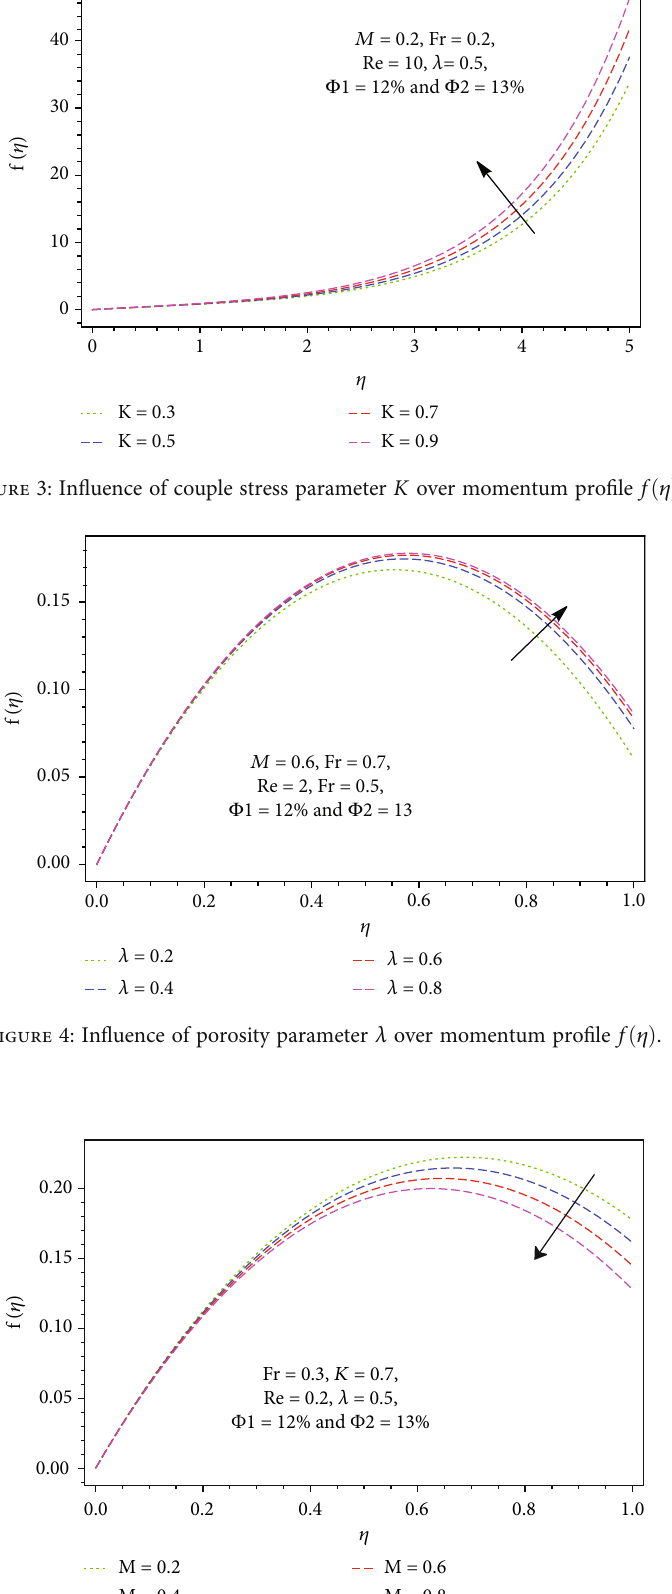
Fr = 0.3, K = 0.7, Re = 0.2, 𝜆 = 0.5,